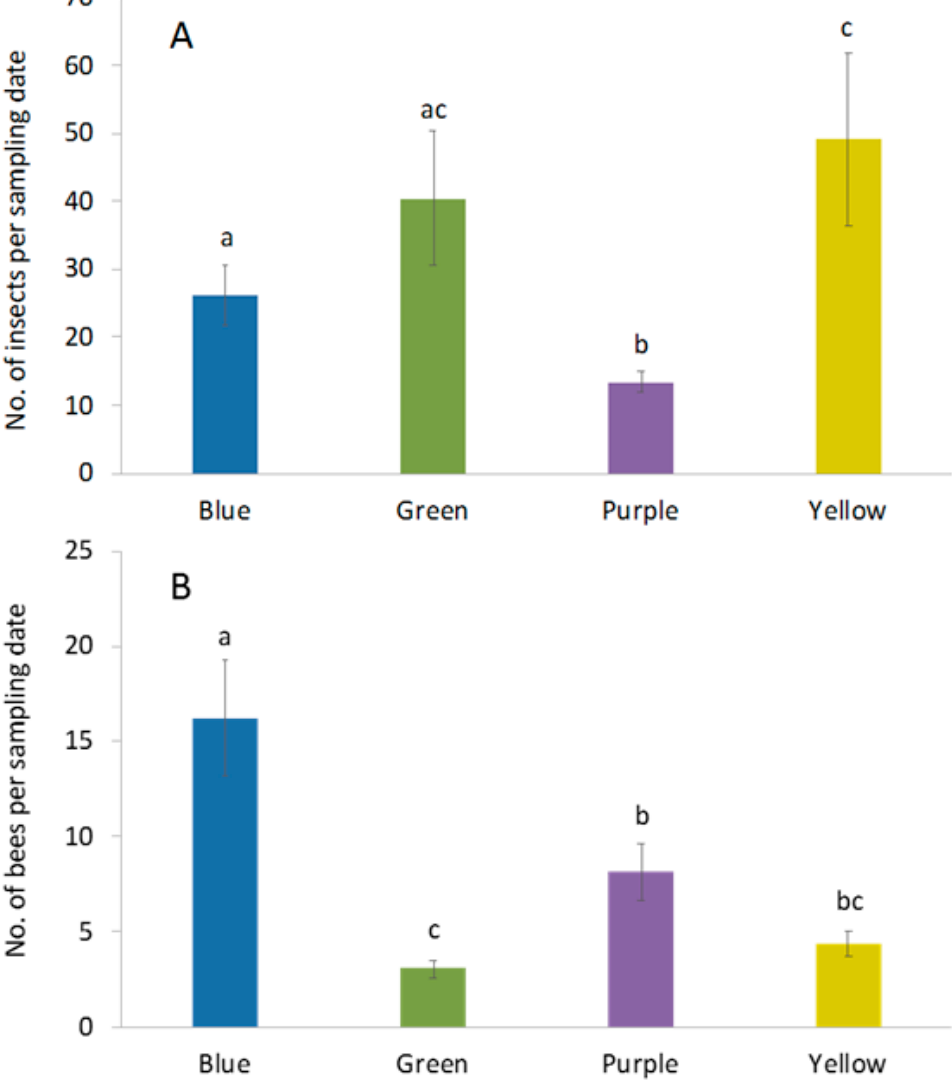
Figure 2. Differences in capture rate (±SE) of ( A ) total insects and ( B ) bees among four pan trap colors in livestock pastures. There were four trap color in each of the 4 plots. Samples were taken 4 times each week for 8 wk. Different lowercase letters indicate significant differences among trap colors ( p < 0.05).